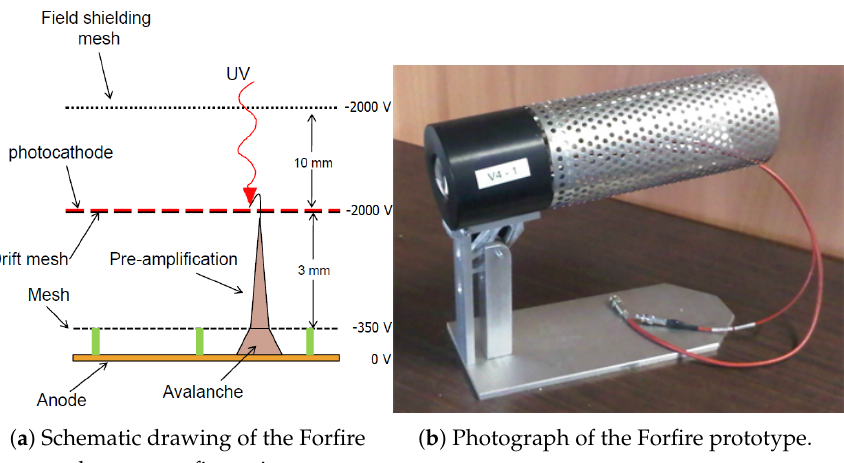
Figure 25. The Forfire Micromegas prototype. An extra mesh allows the decoupling of the photo- cathode from the detector, the use of reflective mode, and an extra amplification